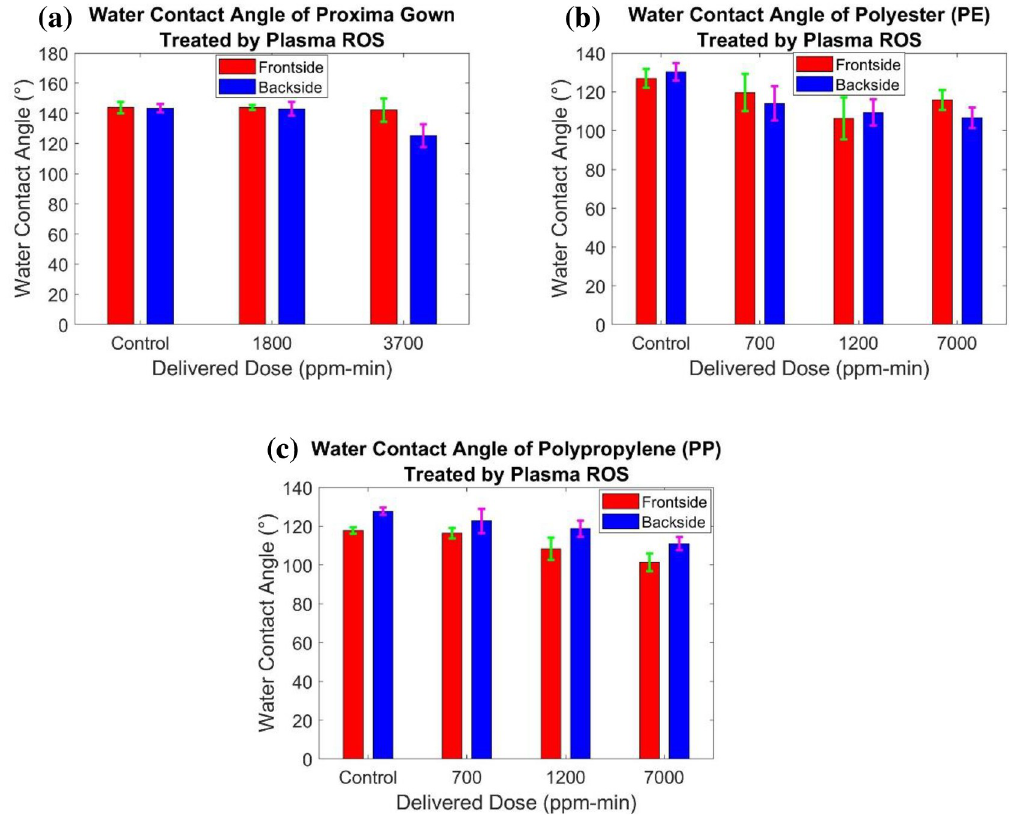
Fig 18. Water contact angle of (a) Proxima gown, (b) polyester, and (c) polypropylene samples treated by Plasma ROS